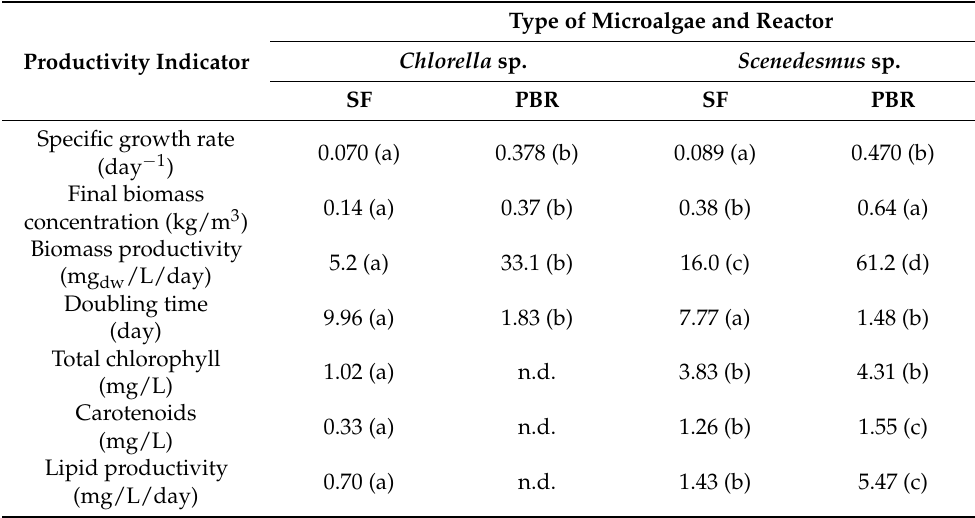
Table 5. Productivity indicators of the two microalgae genera cultivated in the reclaimed water 1 .